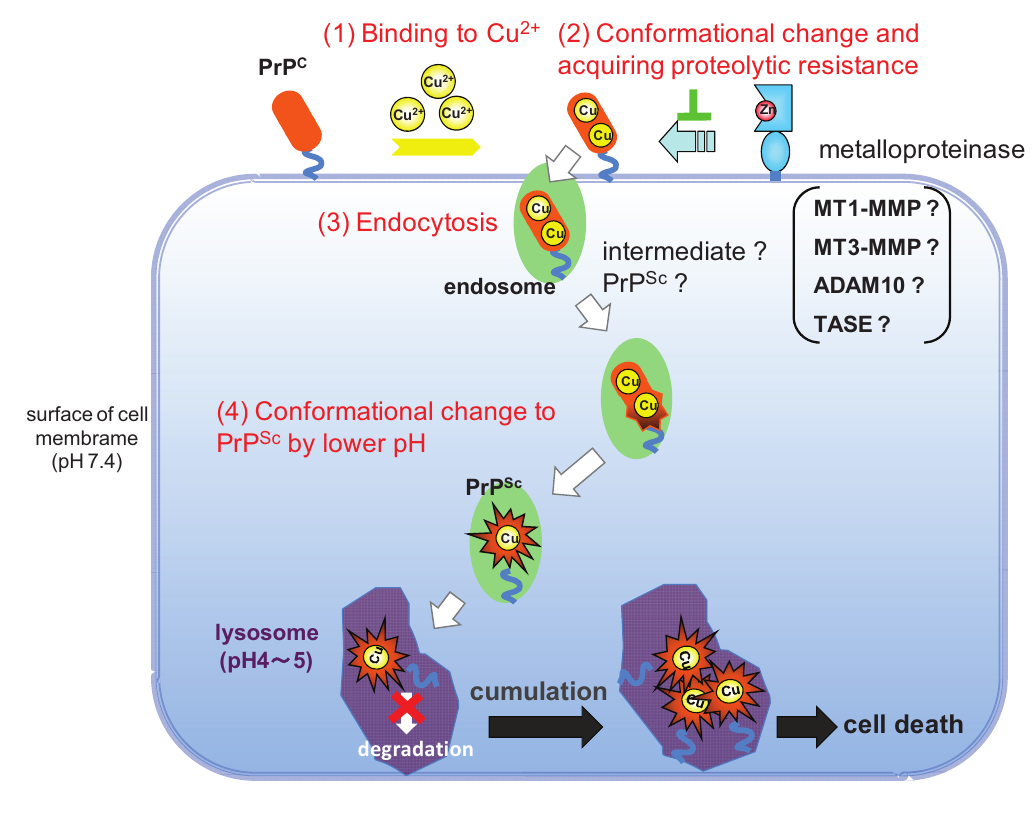
Figure 7. Our hypothesis of the role of membrane-type matrix metalloproteinase and Cu 2+ for the regulation of PrP C . First step ( 1 ) binding to Cu 2+ ; Second step ( 2 ) conformational change and acquiring proteolytic resistance; Third step ( 3 ) endocytosis; Fourth step ( 4 ) conformational change to PrP Sc by lower pH in cell; Final step ( 5 ) aggregation of PrP Sc and cell